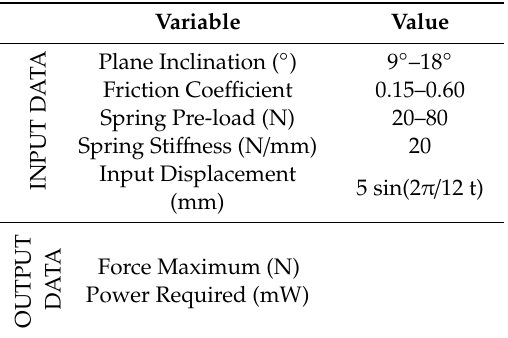
Table 1. Details of multibody model variables.